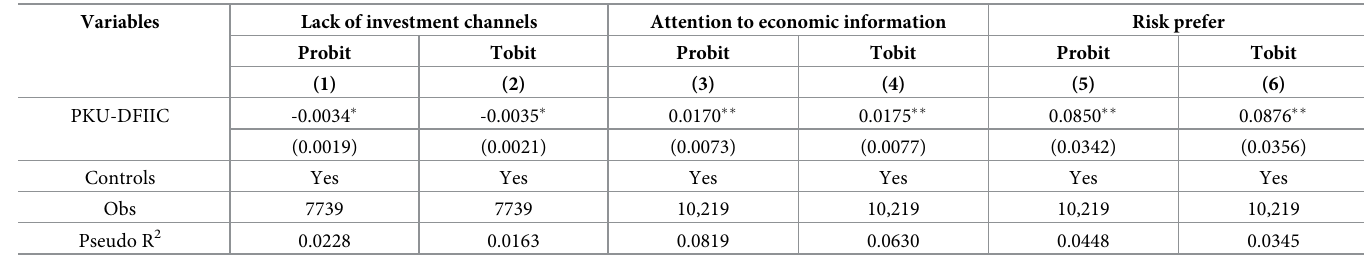
Table 7. Mechanism